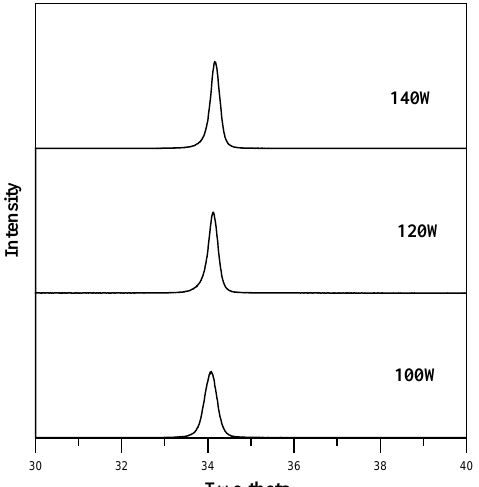
Figure 2 . XRD diffraction patterns for ZnO:Al films deposited at various RF powers and pressure of 3 ×10 -3